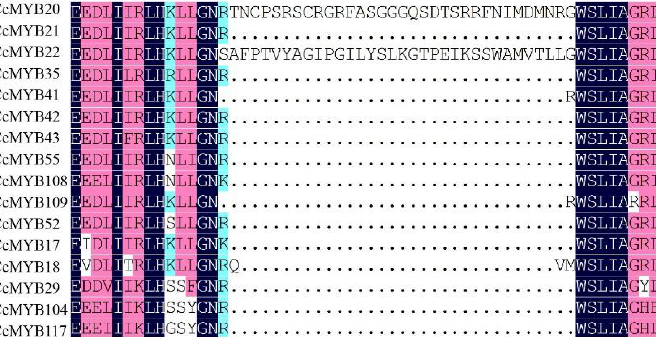
Figure 9. Multiple sequence alignment of R3 structures in subgroups C17, C20, and